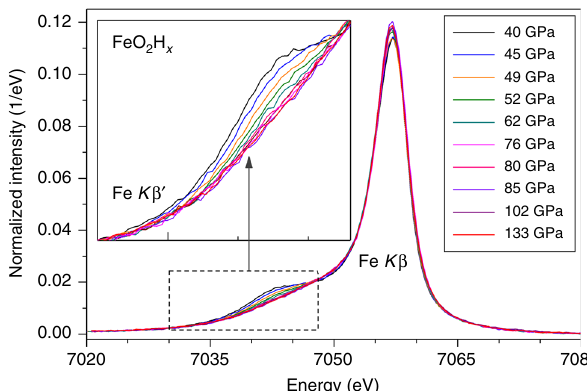
Fig. 3 High-pressure XES spectra of pyrite-structured FeO 2 H x at 300 K. The integrated intensity of the XES spectra was normalized to unity. Inset: the K ′ β satellite emission peak between 7030 and 7048 eV after the iron main emission peaks was aligned to that at 133 GPa. The changes of the satellite peak intensity in FeO 2 H x are attributed to the high-spin to low-spin transition, as the disappearance of the satellite peak has been used as a robust criterion for the electronic spin-pairing transition of iron in